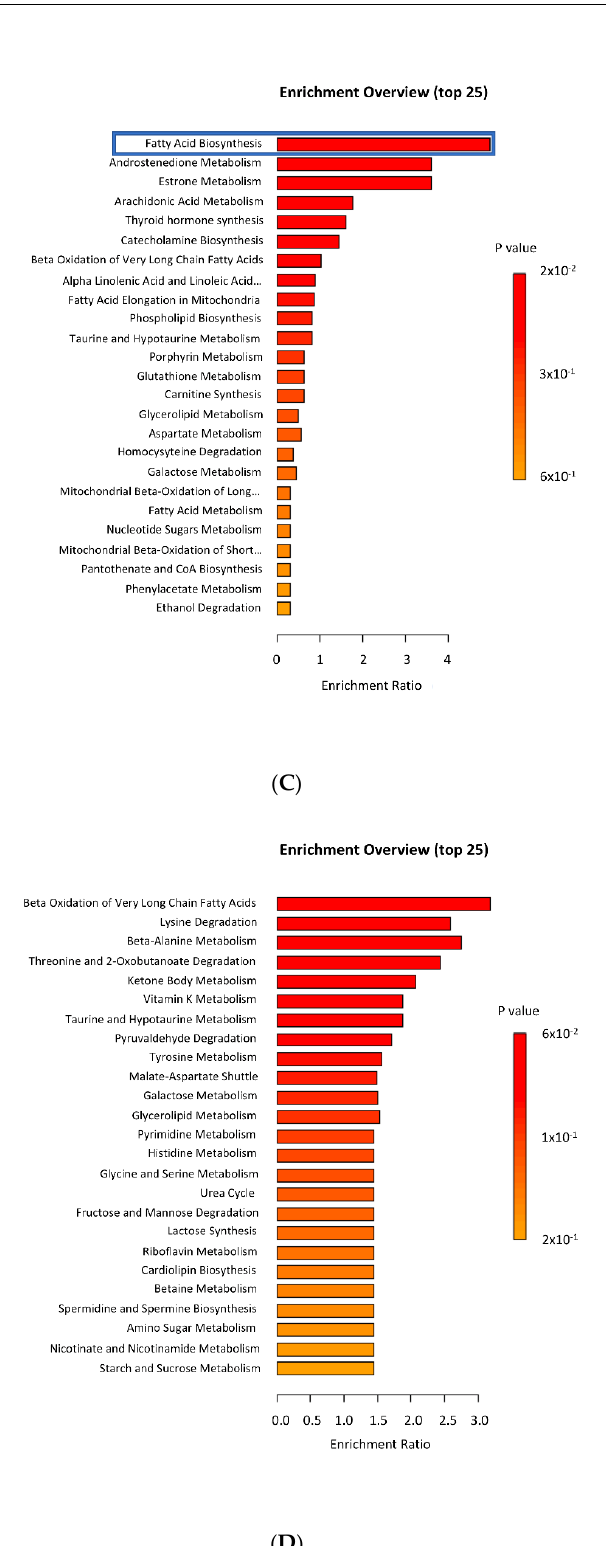
Figure 7. Enrichment metabolites analysis in oocytes and cumulus cells matured with IO+DHEA or ETOMOXIR inhibitors (data compared to control). Pathways that differed significantly ( p ≤ 0.05) were marked with blue squares: ( A ) control vs. IO+DHEA in oocytes; ( B ) control vs. IO+DHEA in cumulus cells; ( C ) control vs. ETOMOXIR in oocytes; ( D ) control vs. ETOMOXIR in cumulus cells. Comparison of control vs. IO+DHEA oocytes showed significant downregulation of fatty acid biosynthesis pathway ( p = 0.015). The following metabolites within